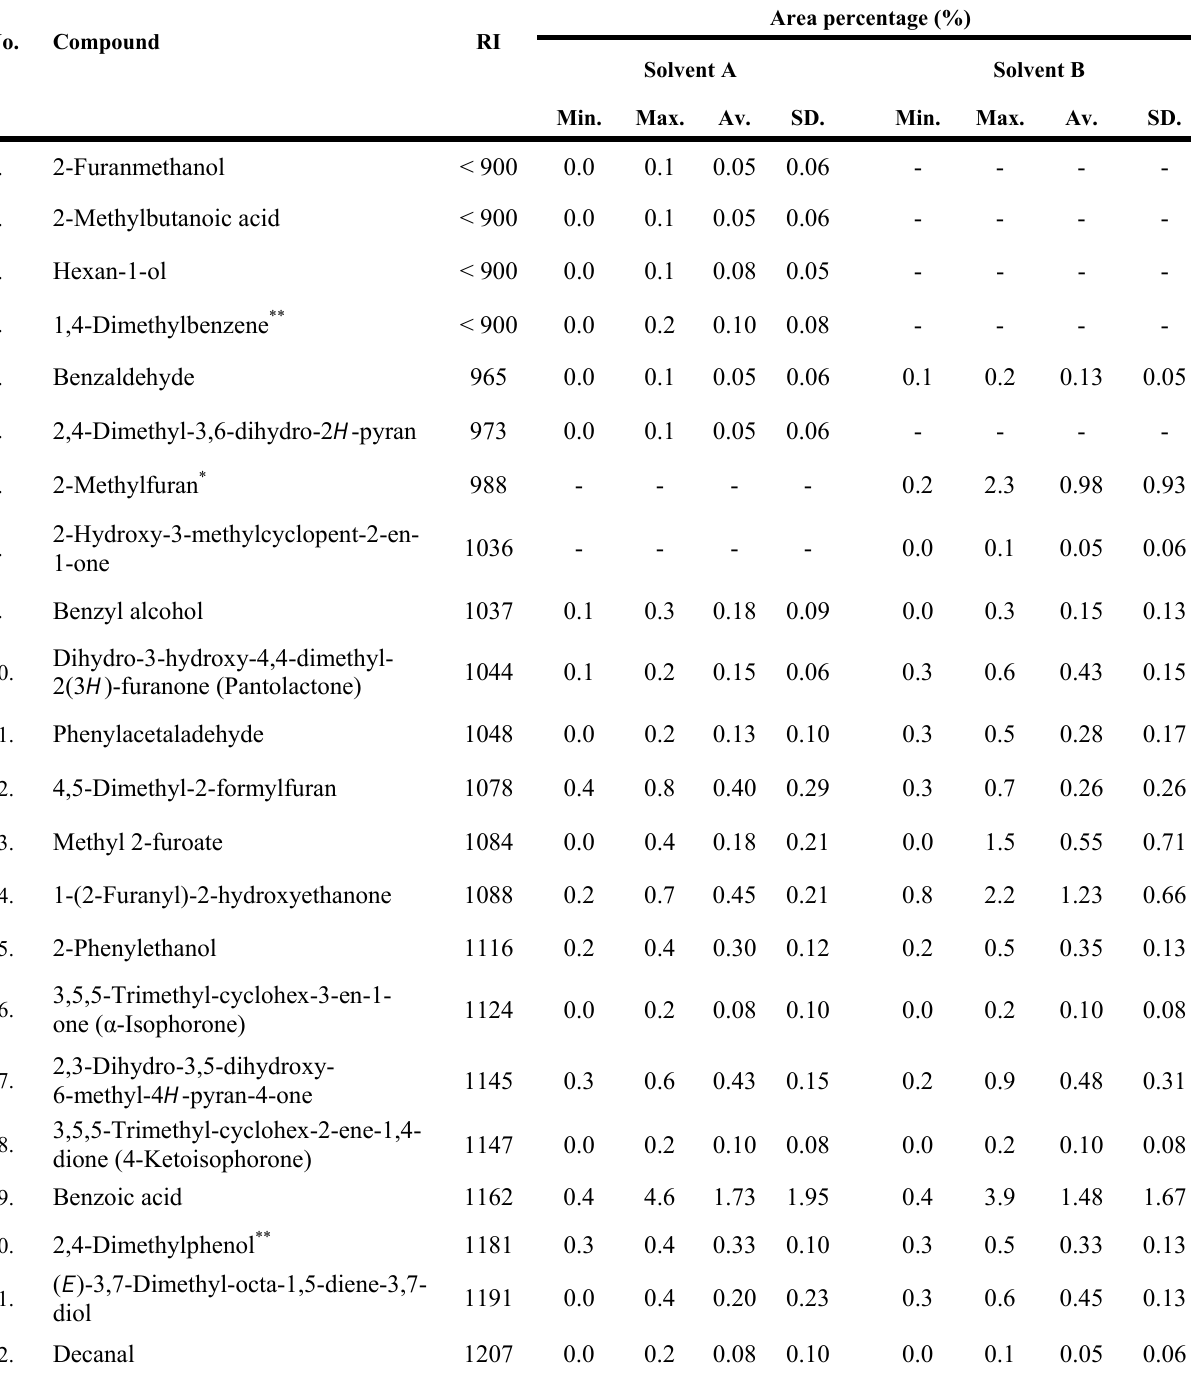
Table 1. Sulla ( Hedysarum coronarium L.) honey volatile organic composition obtained by USE with two solvents followed by GC and GC/MS